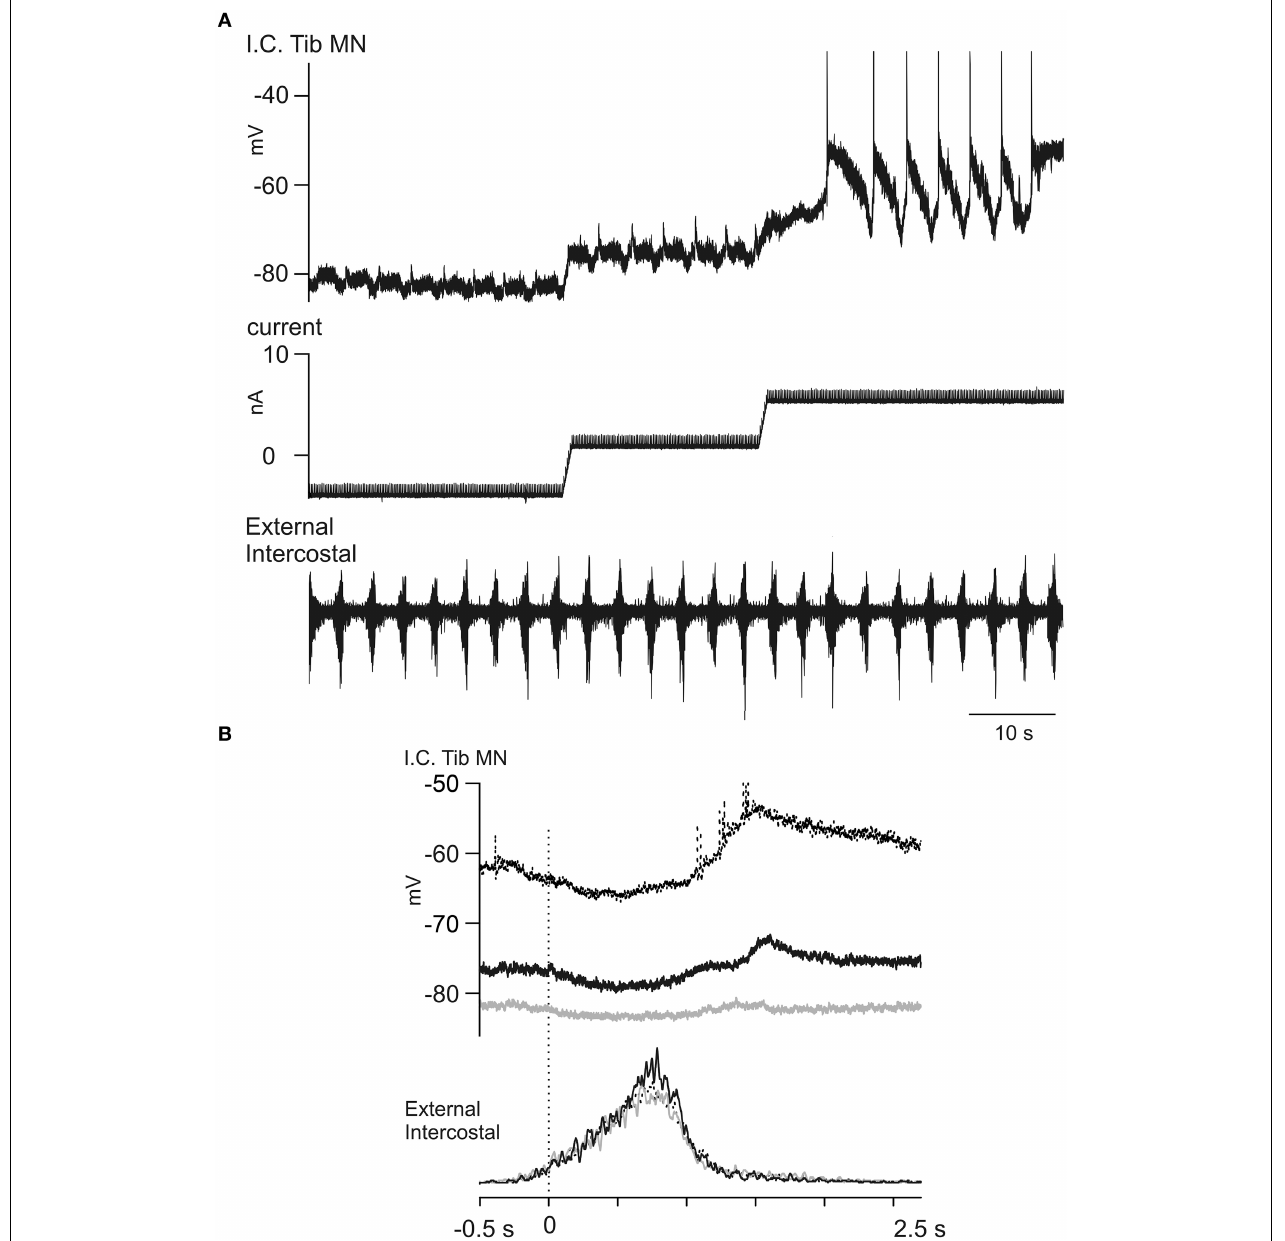
FIGURE 8 | Voltage dependent amplification of an E dec CRDP. (A) The traces show a CRDP in a Tib motoneuron (top) during step-wise current injection (middle) and the T5 external intercostal ENG activity (bottom). The CRDP becomes larger at at more depolarized membrane potential levels. (B) The averaged CRDPs from (A) . The averages were performed separately at the three membrane potential levels